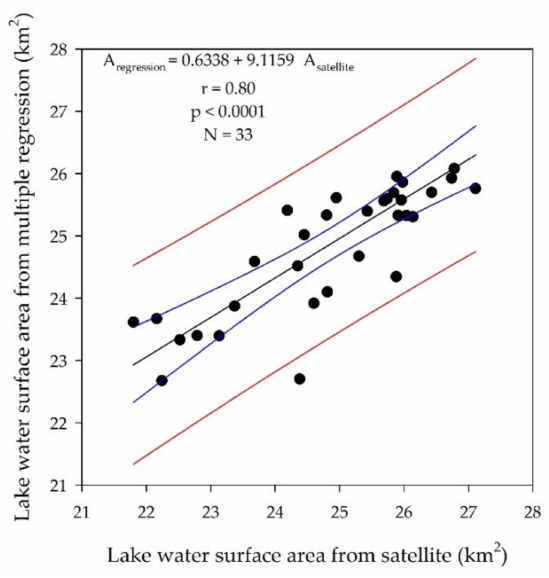
Figure 13. A relationship between lake surface areas estimated from satellite and multiple regression